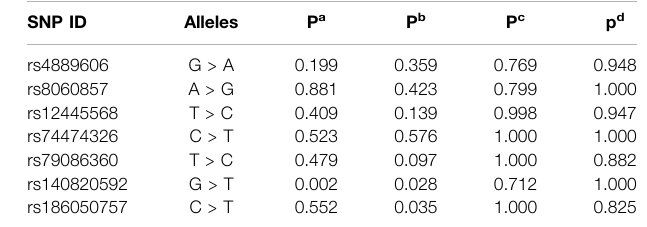
TABLE 3 | Comparison of allele frequency distributions for seven tagging SNPs between cases and controls.